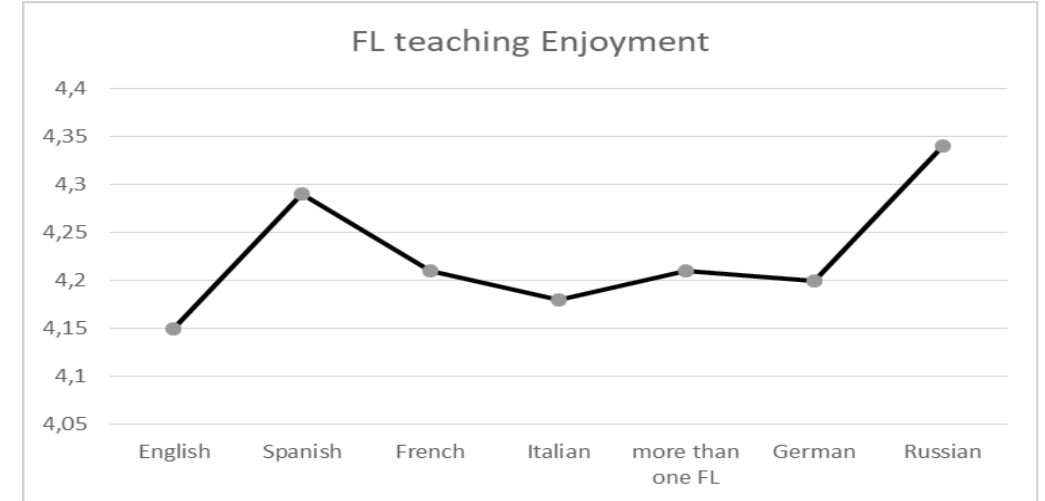
Figure 2. FL teaching Enjoyment according to the